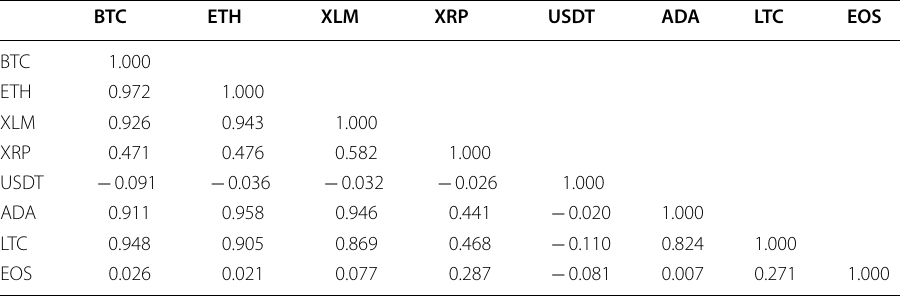
Table 4 Correlation